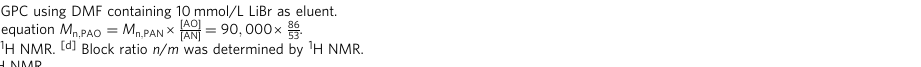
Molecular weight was determined by 1 H NMR. [d] Block ratio n / m was determined by 1 H NMR. d Block ratio n / m was determined by 1H